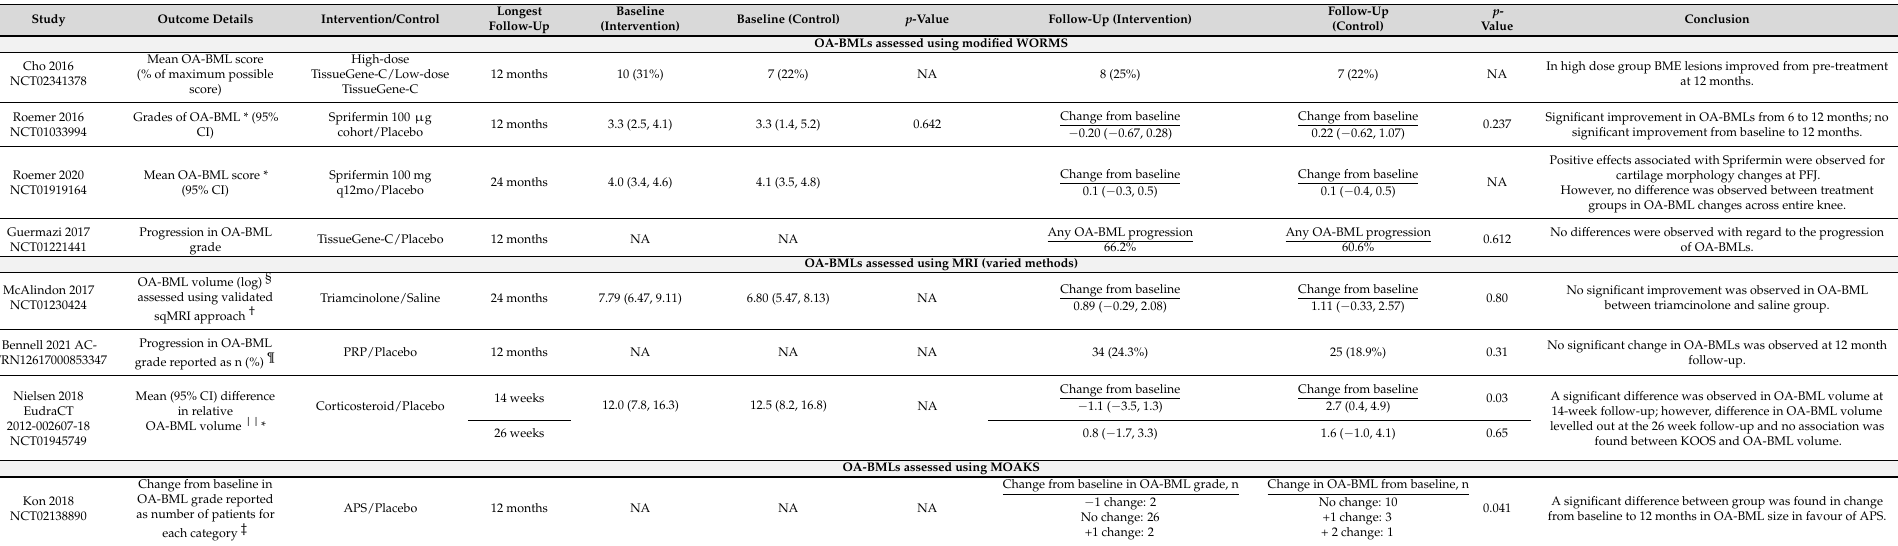
Table 2. Changes in MRI-measured OA-BMLs after treatment at longest reported